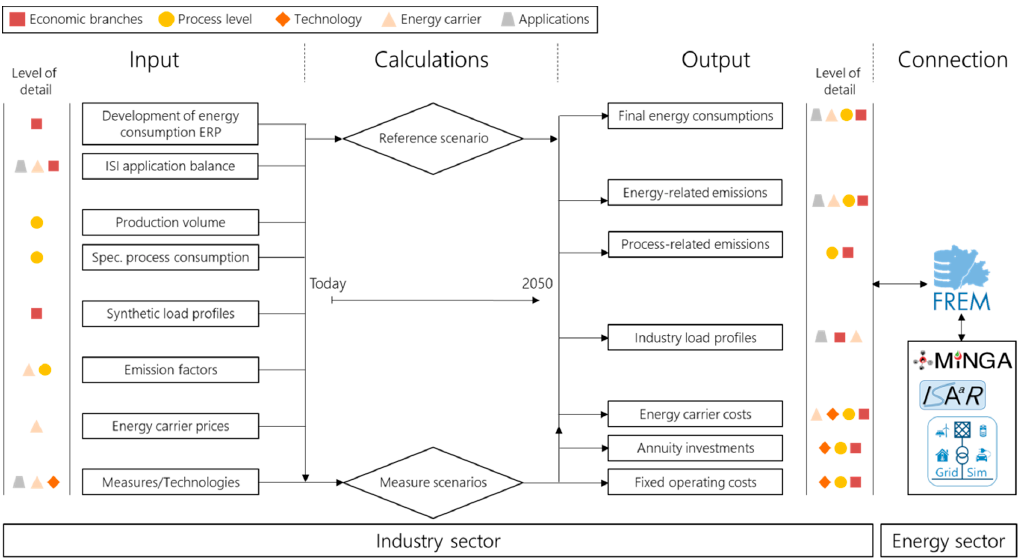
Figure 2. Inputs and outputs of SmInd and integration into the FfE model landscape.